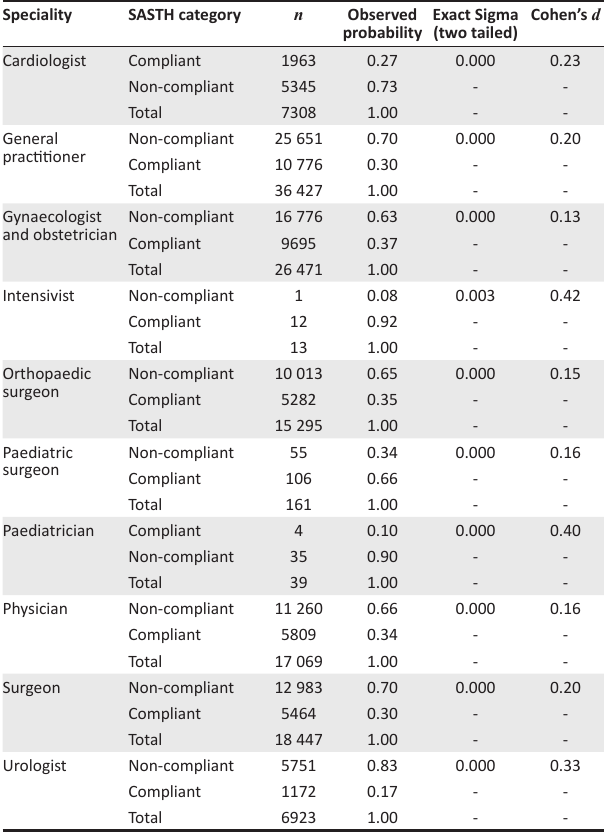
TABLE 4: Distribution of South African Society of Thrombosis and Haemostasis compliancy by doctor